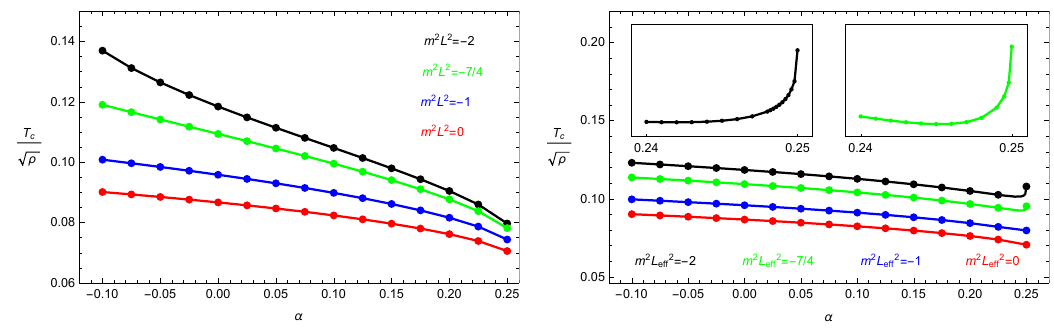
Figure 2 . The critical temperature T c of the scalar operator O + as a function of the Gauss-Bonnet parameter for the fixed masses of the scalar field by choosing values of m 2 L 2 (left) and m 2 L 2